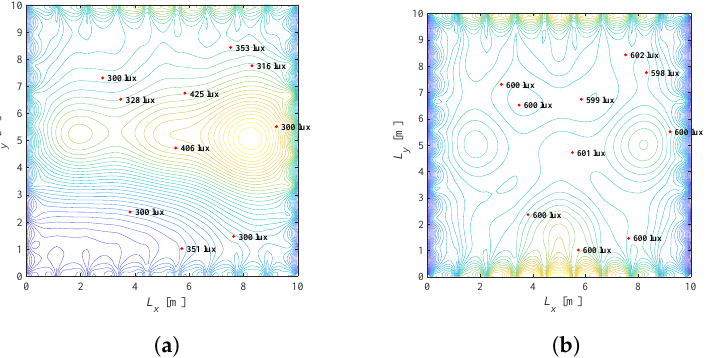
Figure 8. The solution of the Problem 1 defined in (10) while taking into account the direct LoS and the first reflection. ( a ) λ = 0.01, G = 0.36, Φ 1/2 = 60 0 . ( b ) λ = 0.5, G = 0.75, Φ 1/2 = 60 0